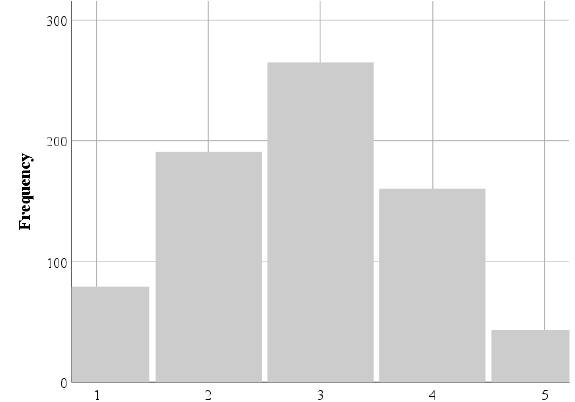
Figure 2: Histogram of the impact of the proposed transport mode by social media information, on mode choice